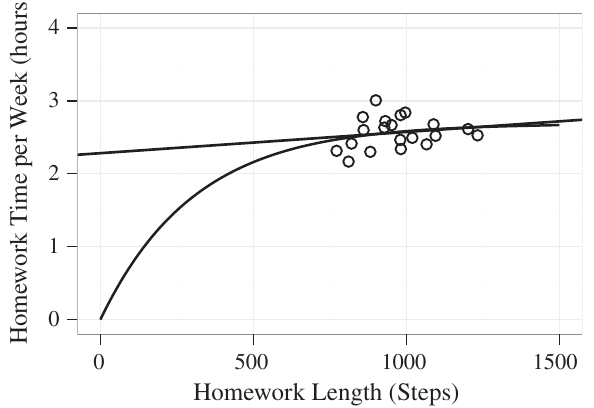
FIG. 6. The total time in hours spent working homework per week plotted against the total length of the homework assign- ments as measured by the number of steps required for their